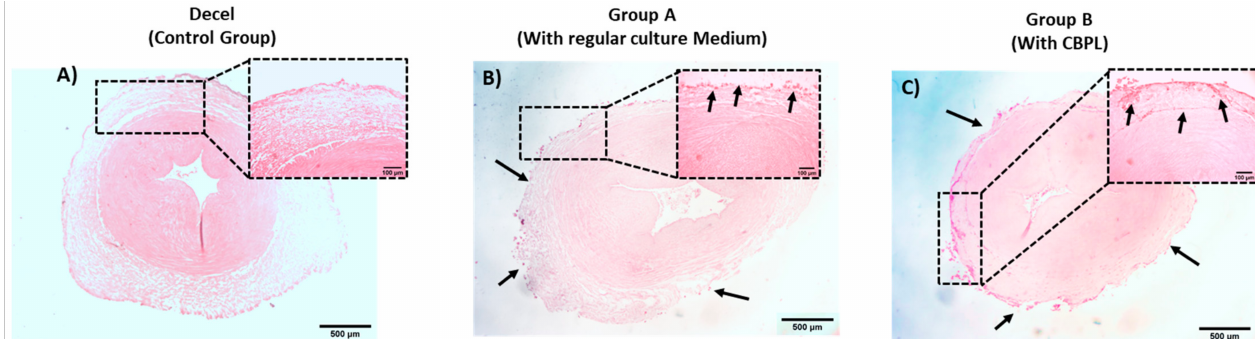
Figure 7. Histological analysis of hUAs ( A – C ). Overview of repopulated hUAs of groups A and B ( B , C ). Decellularized hUA served as the control group ( A ). Repopulated hUA of group A ( B ). WJ-MSCs P3 in group A were located only to the tunica adventitia. Repopulated hUA of group B ( C ). On the contrary, WJ-MSCs P3 in group B migrated successfully to the inner vascular wall. Images represented with original magnification 2.5 × and scale bars 500 µ m. Images in the black squares represented with original magnification 10 × , scale bars 100 µ